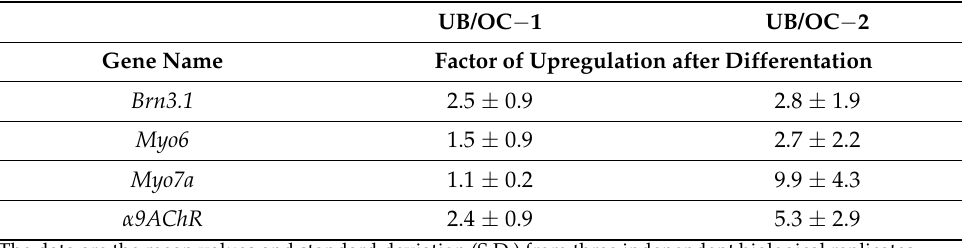
Table 1. Upregulation of hair cell markers through cell differentiation.